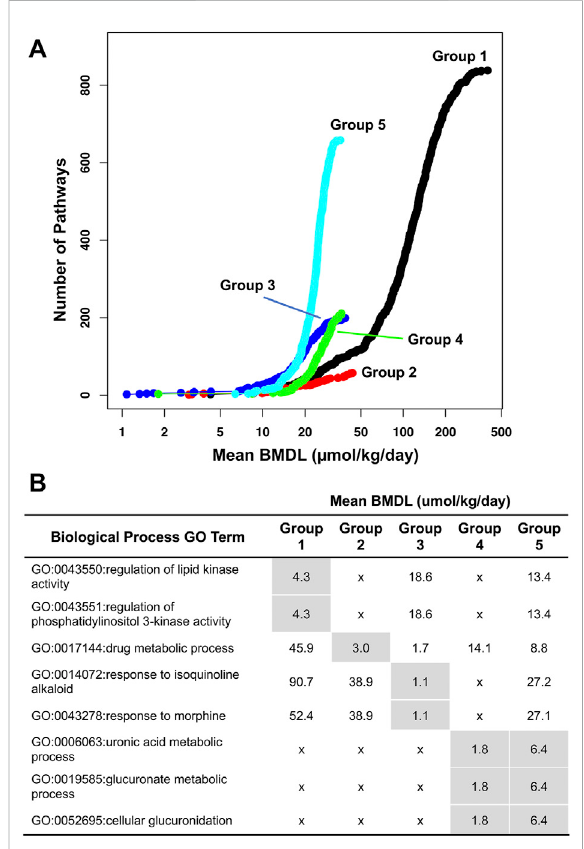
FIGURE 2 Toxicogenomic analysis of the fi ve experimental datasets examined in this study. (A) Visualization of biological process gene ontology (GO) terms in concentration-response with the number of biological processes ( y -axis) for a given level of the mean lower genomic benchmark dose (mean BMDL, x -axis). Group 1 (5 day PBDE-47 study) is shown in black, Group 2 (PBDE-47 at PND4) is shown in red, Group 3 (PBDE-47 at PND 22) is shown in blue, Group 4 (PBDE-mixture at PND4) is shown in green and Group5(PBDE-mixtureatPND22)isshownincyan. (B)